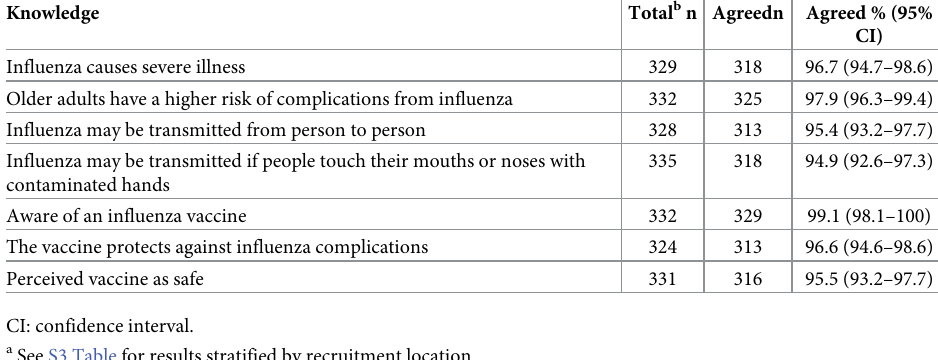
Table 2. Knowledge of influenza vaccination, older adults in nursing homes and daycare centers a , Honduras, August 29 to October 26, 2018.